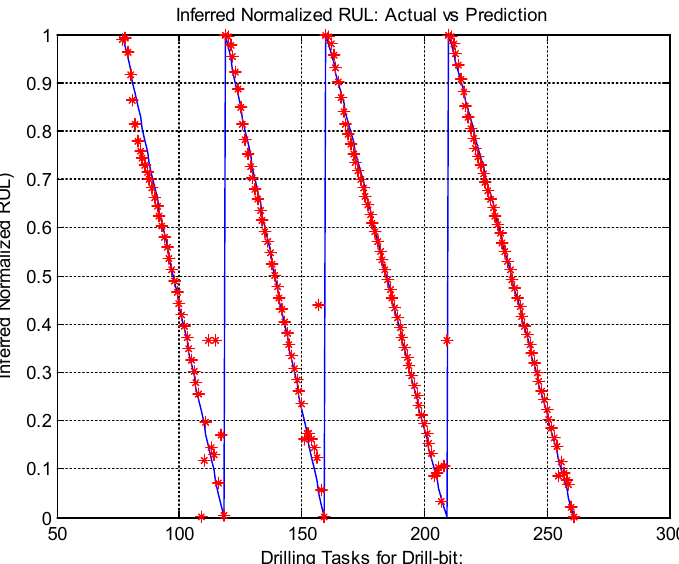
Figure 6. Normalized inferred RUL (blue line) vs. predicted RUL (red dotted line) for drill-bits #5 ~ #8.